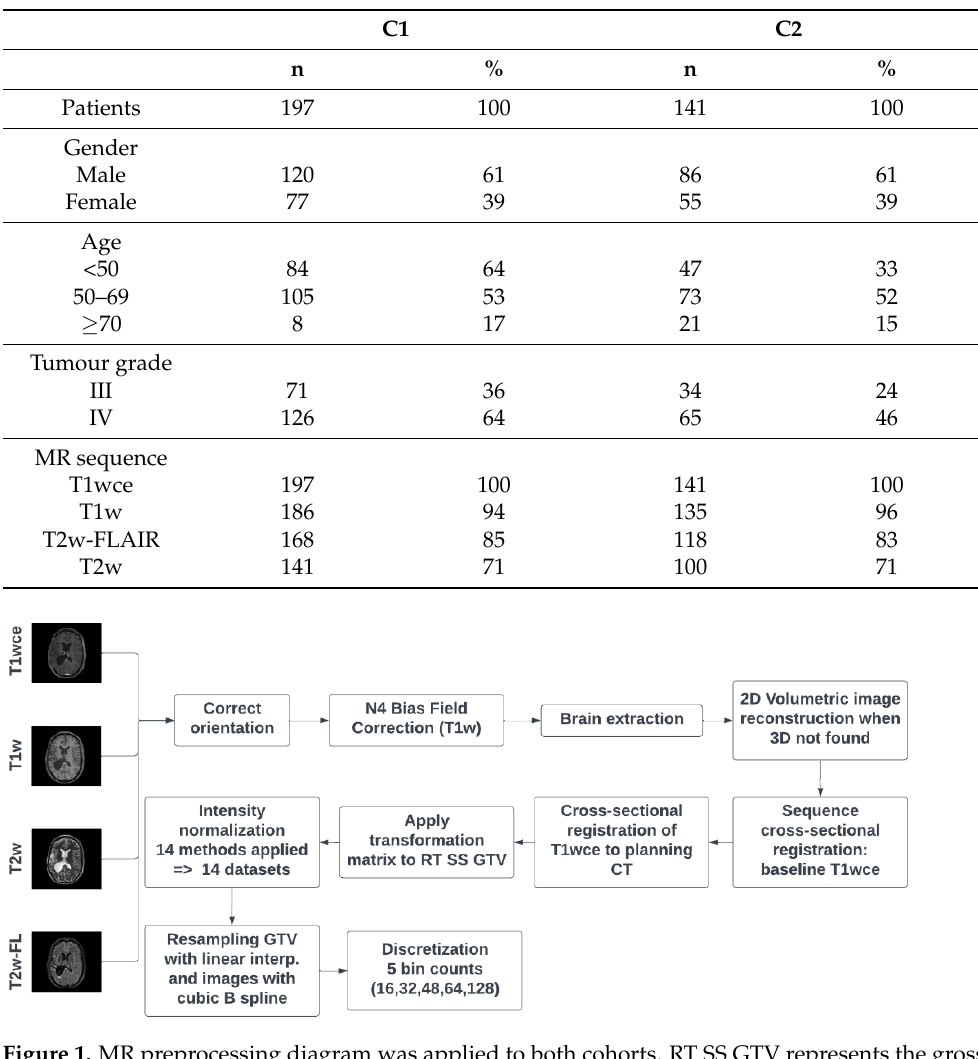
Table 1. Descriptions of the data cohorts C1 and C2 considered in this study.